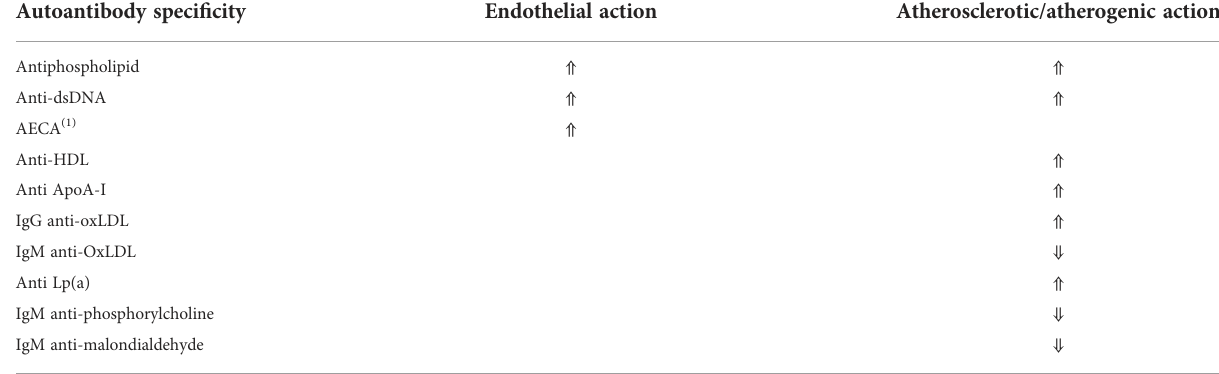
TABLE 1 Mechanism of action of autoantibodies in SLE-associated CVD. Autoantibody speci fi